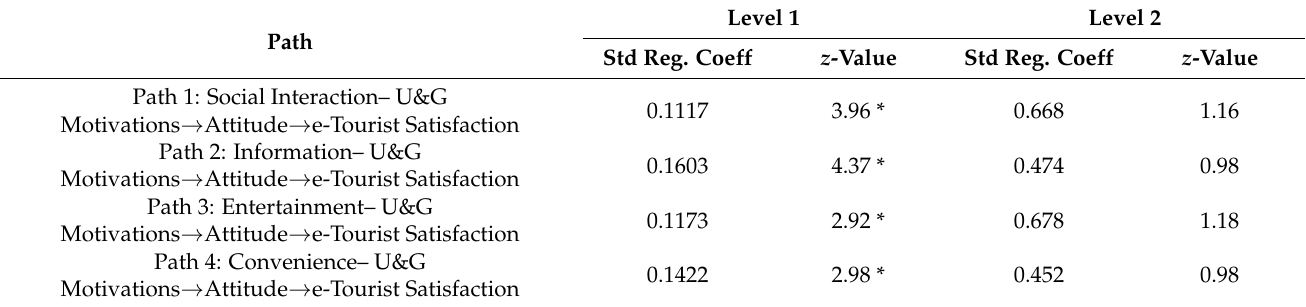
Table 6. Results from the Three Path Relations for the Level 1 and Level 2 Mediation Model.